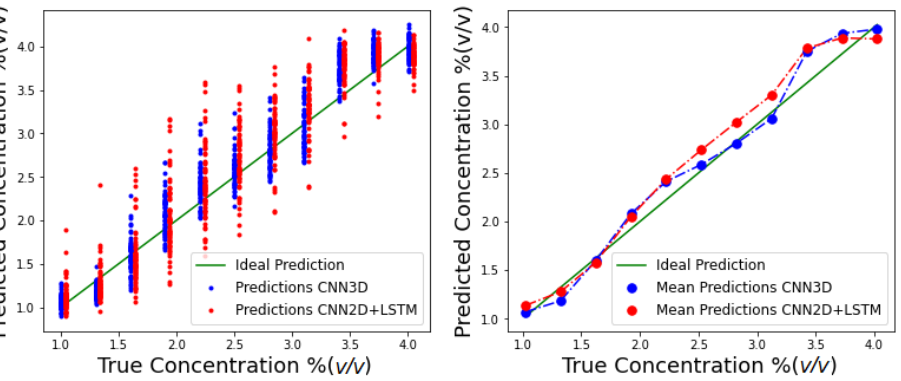
Figure 11. CNN3D and CNN2D+LSTM test set concentration predictions. ( Left ) individual droplet predictions; ( Right ) average predictions.